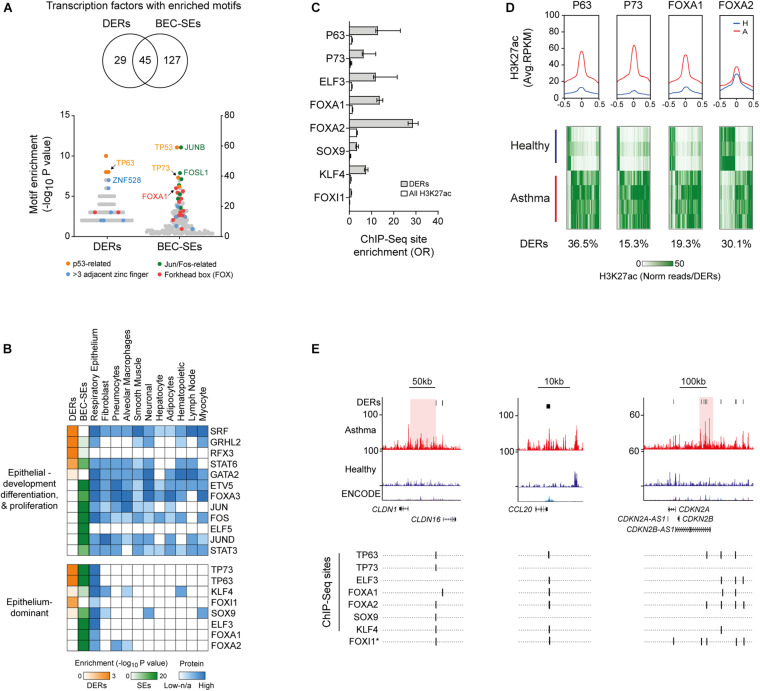
Identification of airway epithelium-dominant transcription factors (TFs) associated with H3K27ac in asthma. (A) Enrichment of TF motifs across asthma DERs and BEC-SEs. Examples of the most enriched and prevalent TF families are indicated. (B) Heat map depicting motif enrichment, protein expression, and tissue distribution of TFs enriched in asthma DERs and BEC-SEs, although representing most enriched TFs which were expressed across many tissue types. However, a subset of TFs was expressed almost exclusively in the respiratory epithelium (bottom panel). (C) Enrichment of DERs at epithelium-dominant TF-binding sites identified via ChIP-Seq. All enrichments in DERs and H3K27ac in BECs were significant (P < 0.0001, Fisher’s odds ratio ± 95% CI). (D) H3K27ac profiles of healthy (blue) and asthma (red) BECs at epithelium-dominant TF-binding sites identified via ChIP-Seq. Plots represent enrichment ± 0.5 kb around the binding site center. Heatmaps depict H3K27ac enrichment for each DER containing epithelium-dominant TF-binding sites across study volunteers. Proportion of total DERs with sites indicated below. (E) H3K27ac enrichment and ChIP-Seq-validated or predicted (∗) epithelium-dominant TF-binding sites across epithelial, cell recruitment, and cell cycle-associated genes. CLDN1 and CDKN2B-AS1 are encompassed by asthma-associated SEs (red).